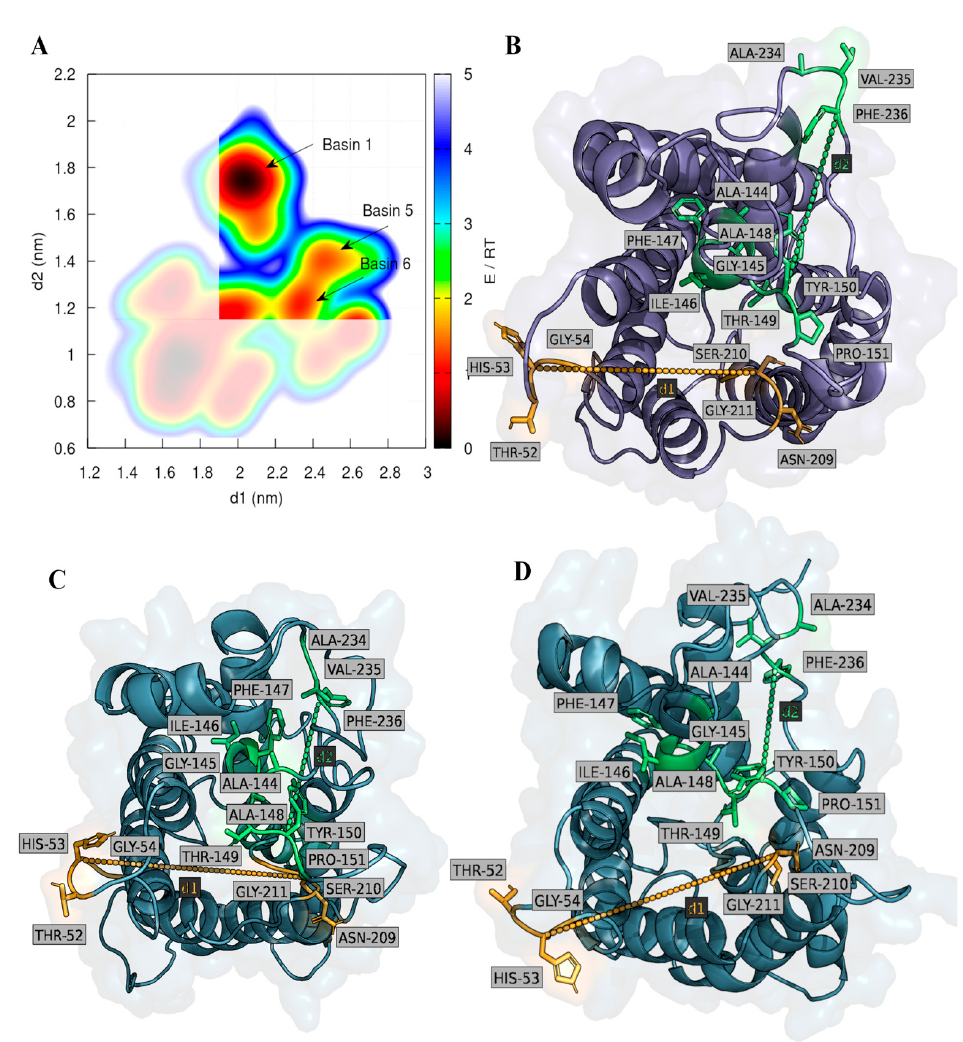
Figure 5. ( A ) Free-energy landscape of d1 and d2, calculated from the conformational sampling of the AQP3 system fully embedded in a POPC membrane bilayer. ( B – D ) highlight structural representative configurations of AQP3 monomers extracted from basins 1, 5, and 6, respectively. In these figures, d1 and d2 used as references are highlighted in yellow and green, respectively.